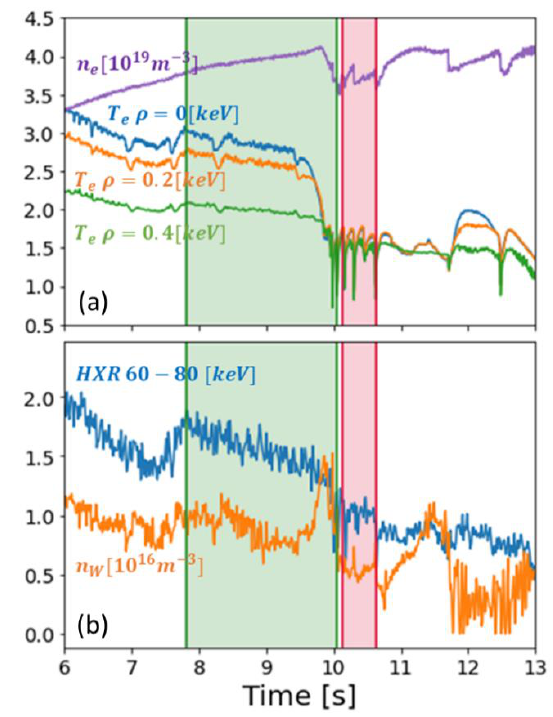
Figure 8: WEST shot 55025. (a) Electron temperature at different radial locations, line-averaged electron density; (b) HXR emission in the energy band 60-80 keV and estimated central tungsten density (adapted from Ref. [9]).